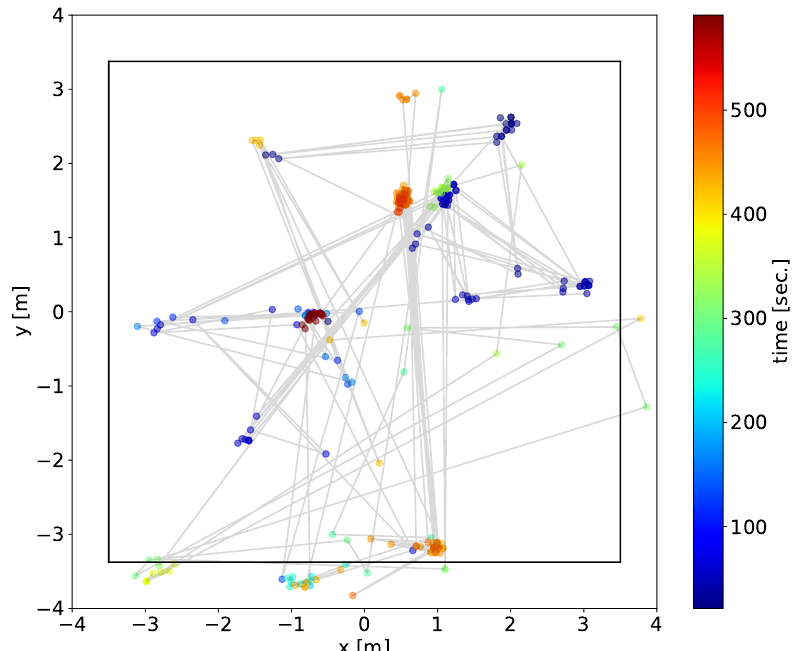
Figure 6. Spatial distribution of localized sound sources. The color corresponds to the localized time represented by the color bar. Each localized sound source is connected to the subsequent one by a gray